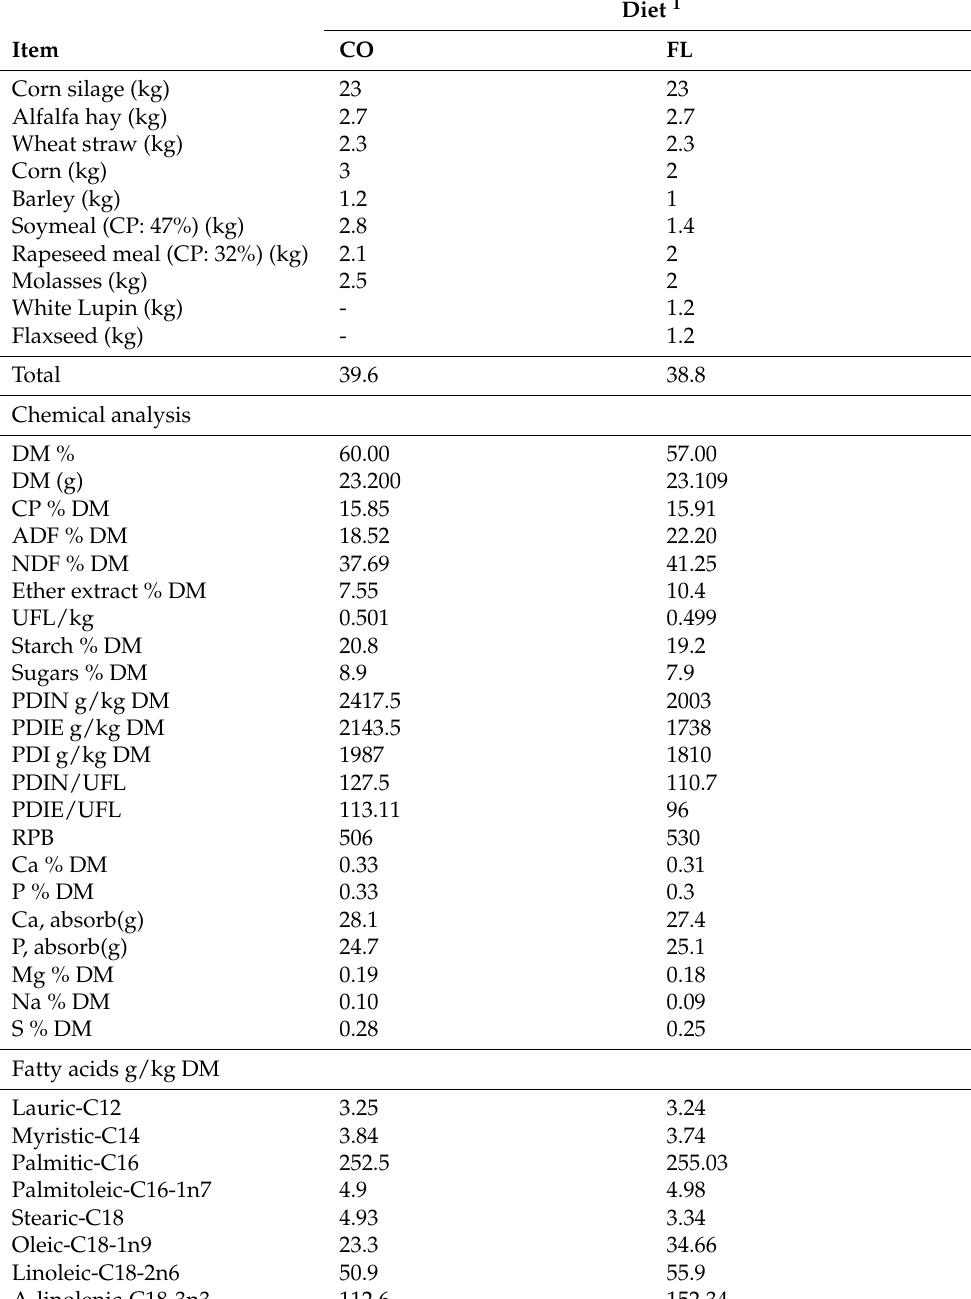
Table 1. Daily ingredient allowance and chemical composition of the TMR offered to dairy cows during the experimental